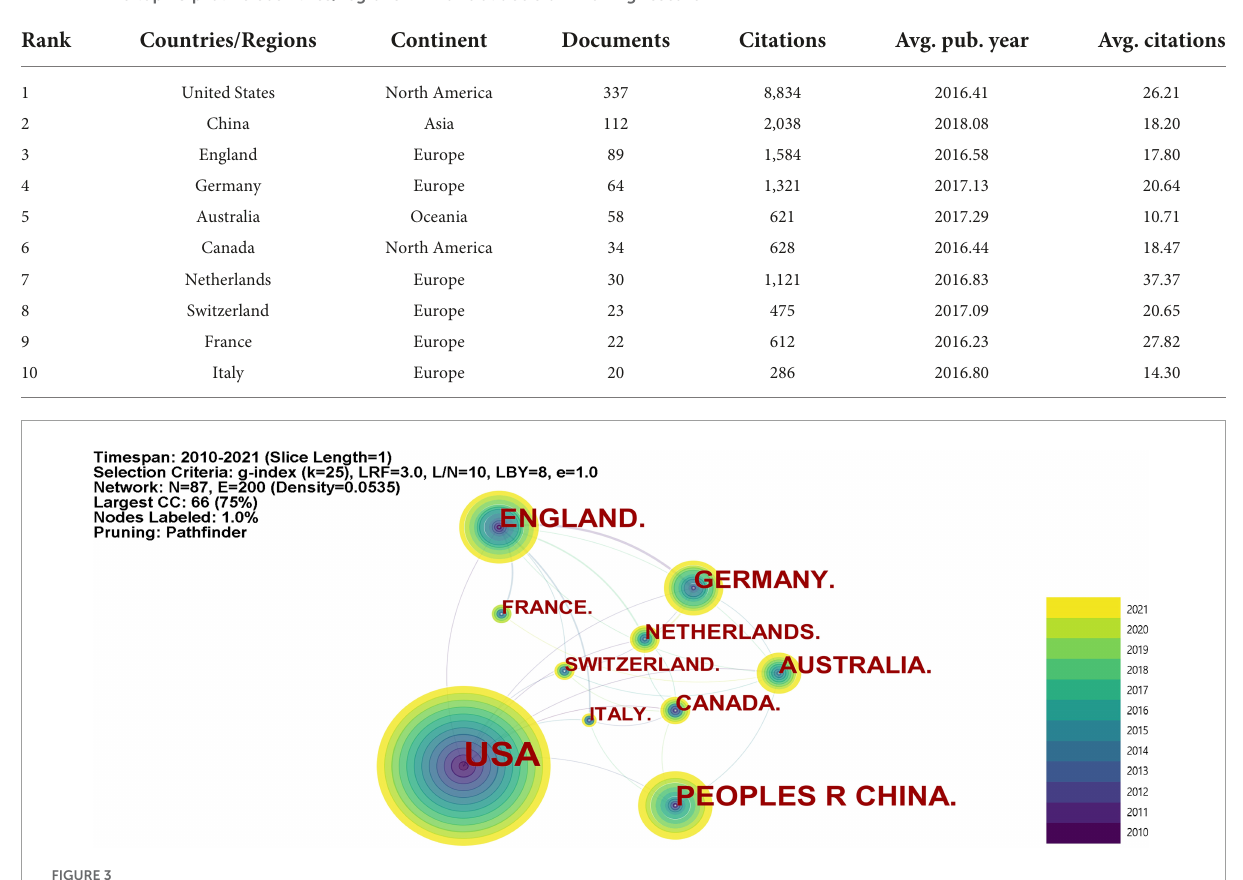
various disciplines in the scientific community. Figure